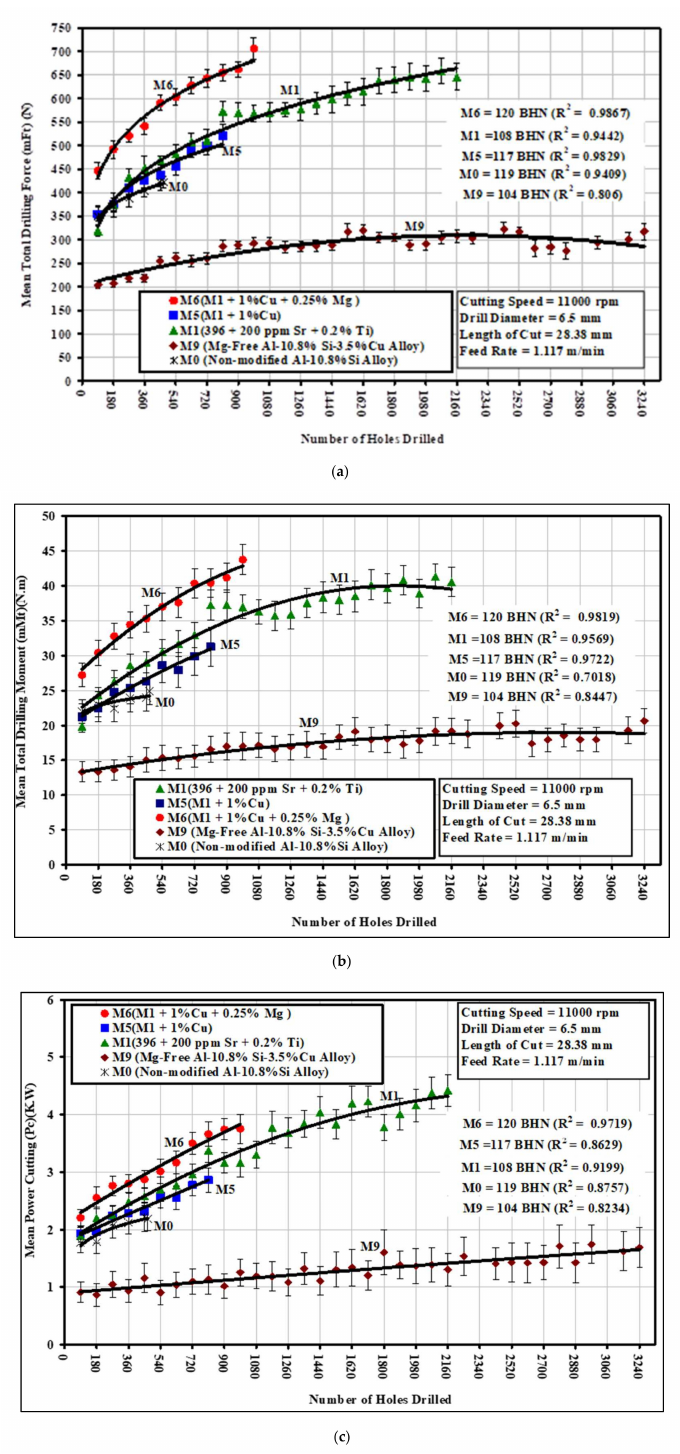
Figure 14. Effects of the addition of Cu, Mg, and Sr on the machinability of M1, M5, M6, M0, and M9 alloys in terms of ( a ) mean total drilling force, ( b ) mean total drilling moment, and ( c ) mean power cutting required for the drilling of 90